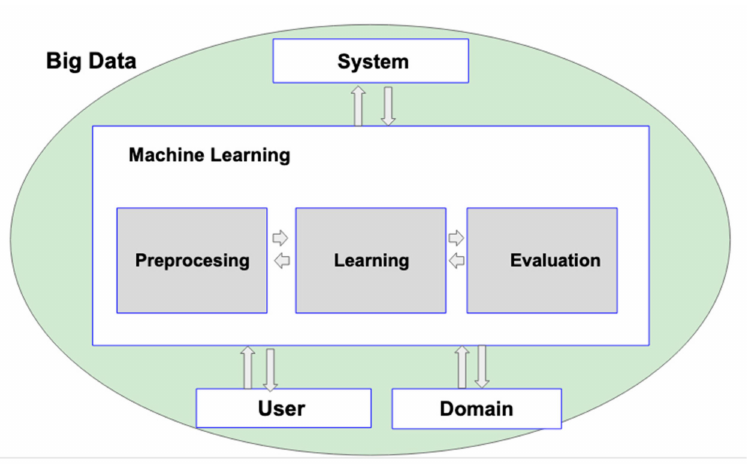
Figure 3. A framework of Machine Learning in Big